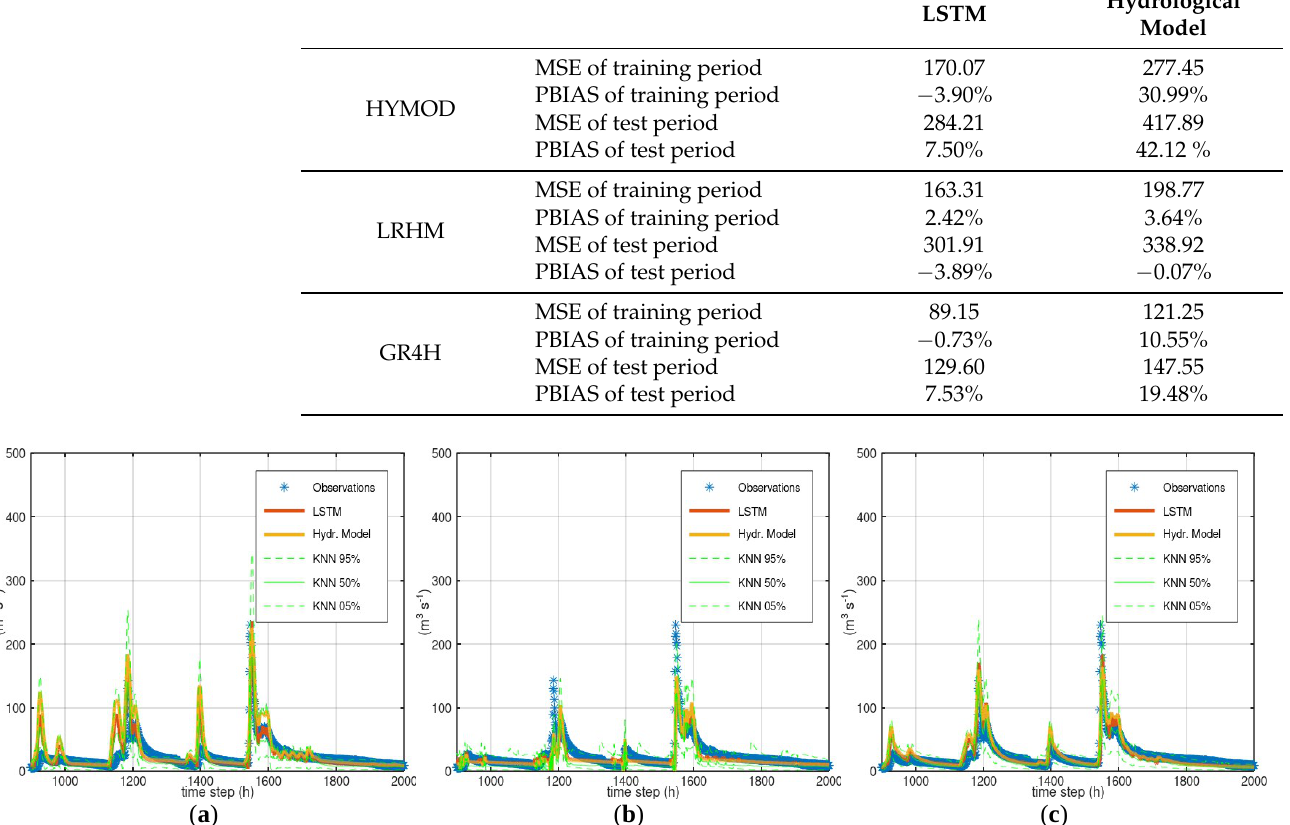
Figure 7. Simulation of Sieve River, for time steps 900–2000 of the test period: ( a ) HYMOD (note how LSTM moderates the erroneous peak flows); ( b ) LRHM (note that LSTM does not repair the occasional failure of the hydrological model at high flows); and ( c ) GR4H.